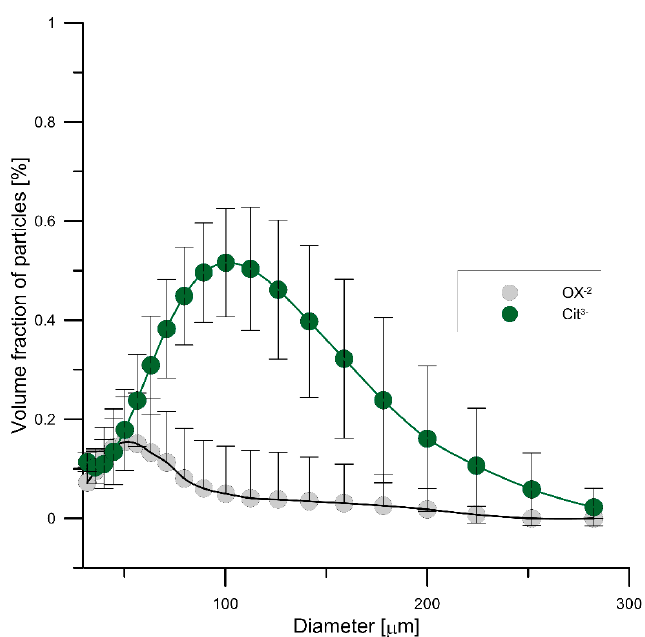
Figure 9. Particle size distribution of the hydroxyapatite samples conditioned for 14 days in a solution with 0.001 mol/dm 3 NaCl + 0.001 mol/dm 3 oxalate ions (grey circle), HAp of 0.001 mol/dm 3 NaCl + 0.0001 mol/dm 3 citrate ions (green circle).